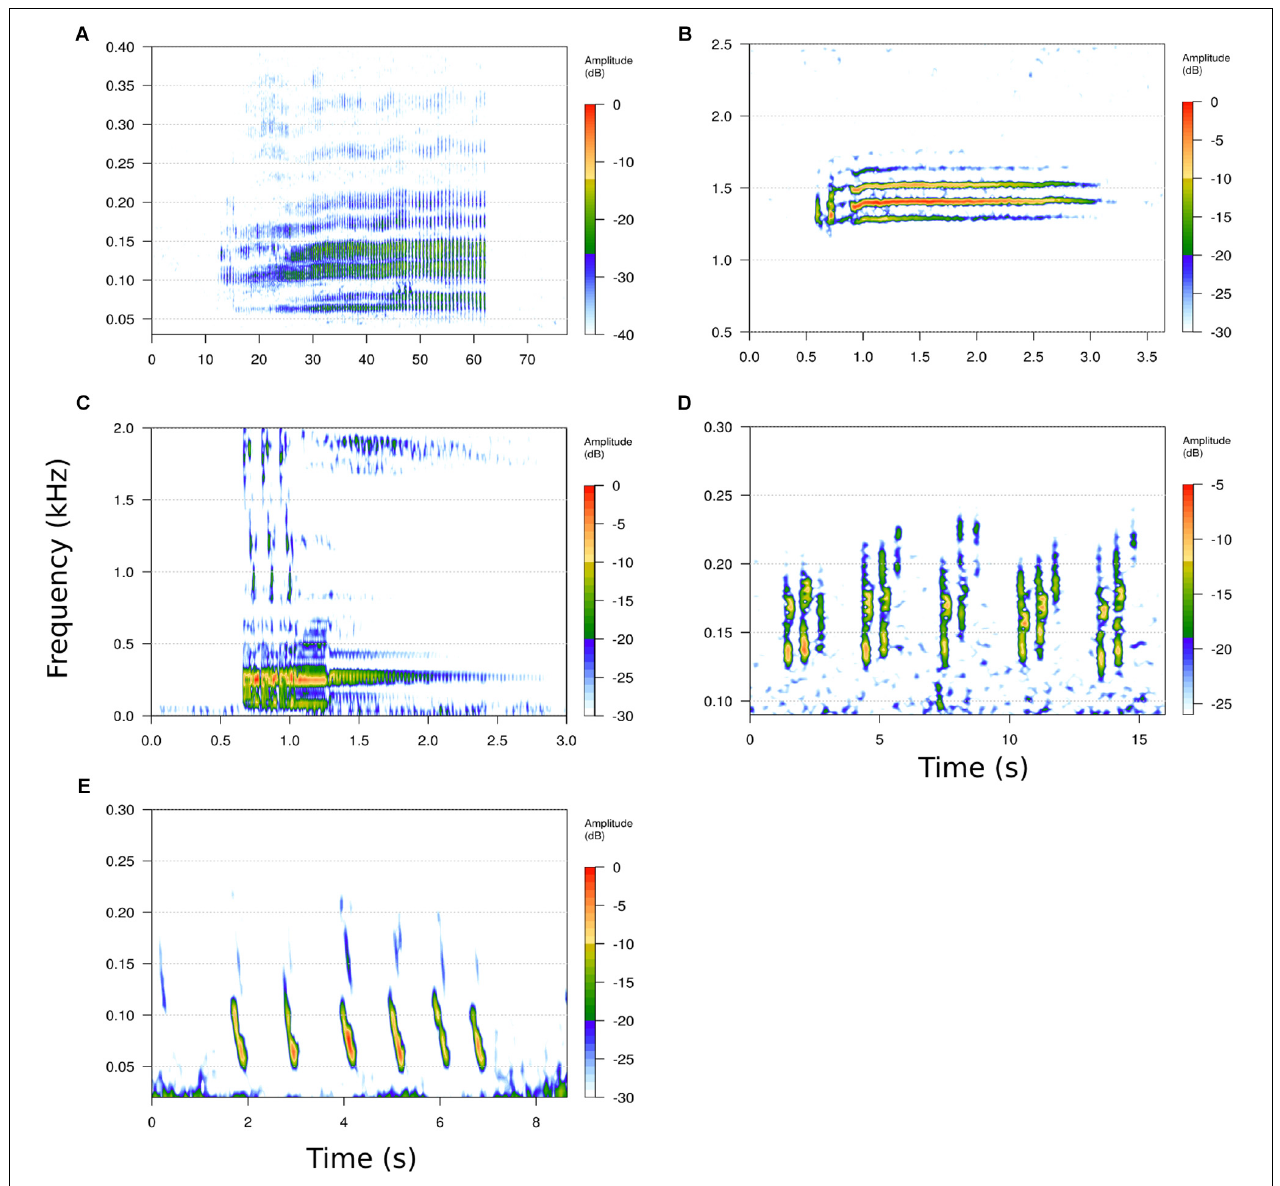
FIGURE 2 | Spectrograms of known minke whale vocalizations from different oceanbasins. (A) North Atlantic slow-down pulse trains, (B) North Pacific “boing” vocalization, (C) Australian dwarf minke whale “star wars” vocalization, (D) Antactic “bioduck,” (E) Antarctic downsweeps. Note different time and frequency scales. Spectrogramparameters: (A) Fast Fourier Transform (FFT) = 1024 pt, overlap (ovlp) = 75%,samplerate (SR) = 2000 Hz: frequency resolution (FR) = 1.9 Hz, time resolution (TR) = 128 ms; (B) FFT = 512 pt, ovlp = 75%, SR = 8000 Hz: FR = 15.6 Hz, TR = 16 ms; (C) FFT = 512 pt, ovlp = 75%, SR = 16,000 Hz: FR = 31.5 Hz, TR = 8 ms; (D) FFT = 1024pt, ovlp = 75%, SR = 4000 Hz: FR = 3.9 Hz, TR = 64 ms; (E) FFT = 4096 pt, ovlp = 75%, SR = 25,811 Hz: FR = 6.3 Hz, TR = 39